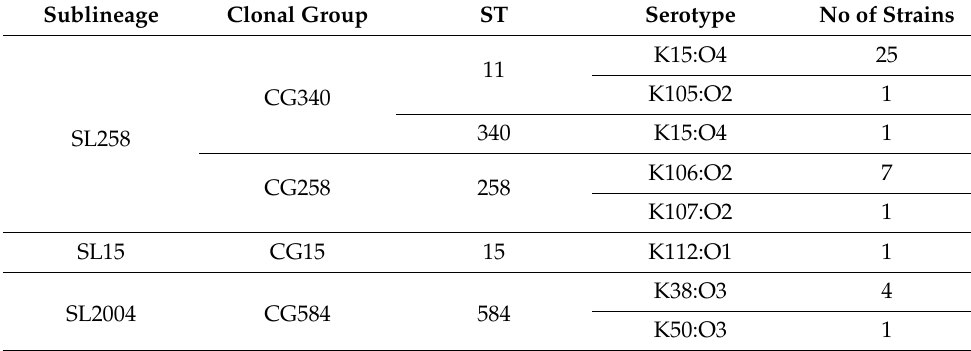
Table 2. Characterization of 41 CR K. pneumoniae